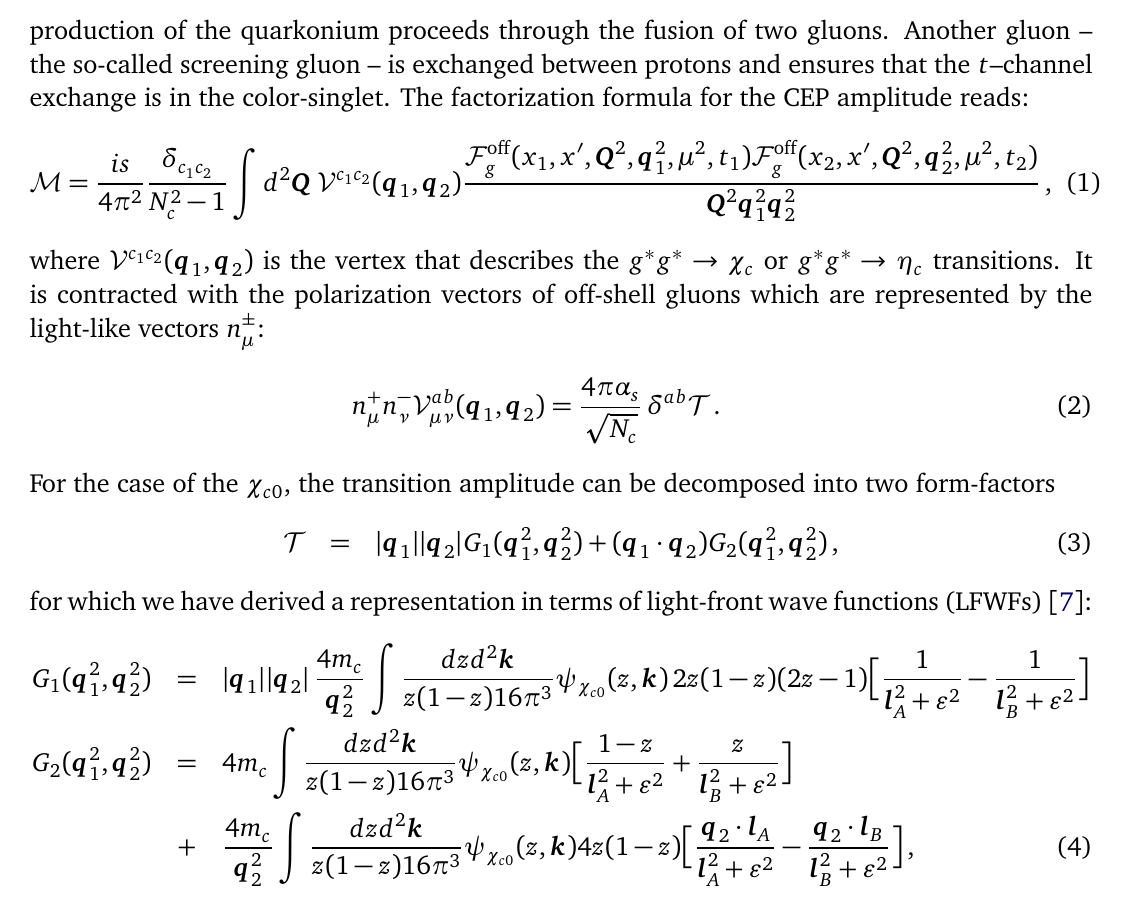
Figure 1: A Feynman diagram for the CEP